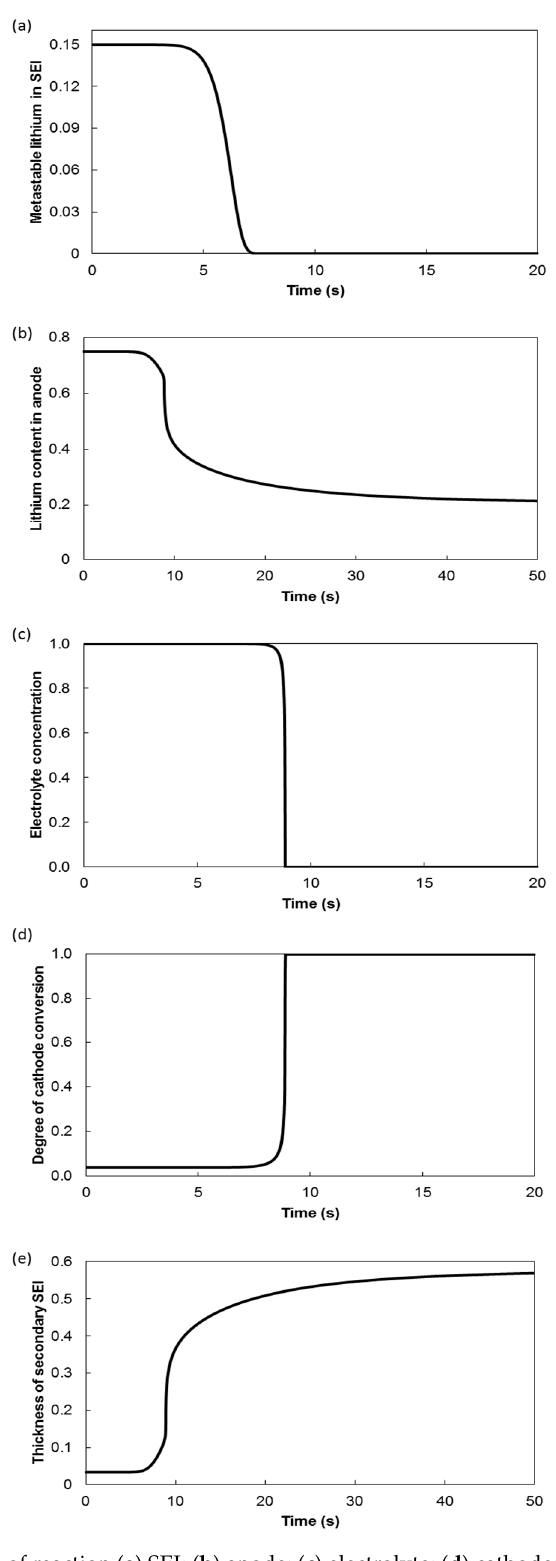
Figure 5. The progress of reaction ( a ) SEI; ( b ) anode; ( c ) electrolyte; ( d ) cathode; and ( e ) secondary SEI thickness, during short-circuit.